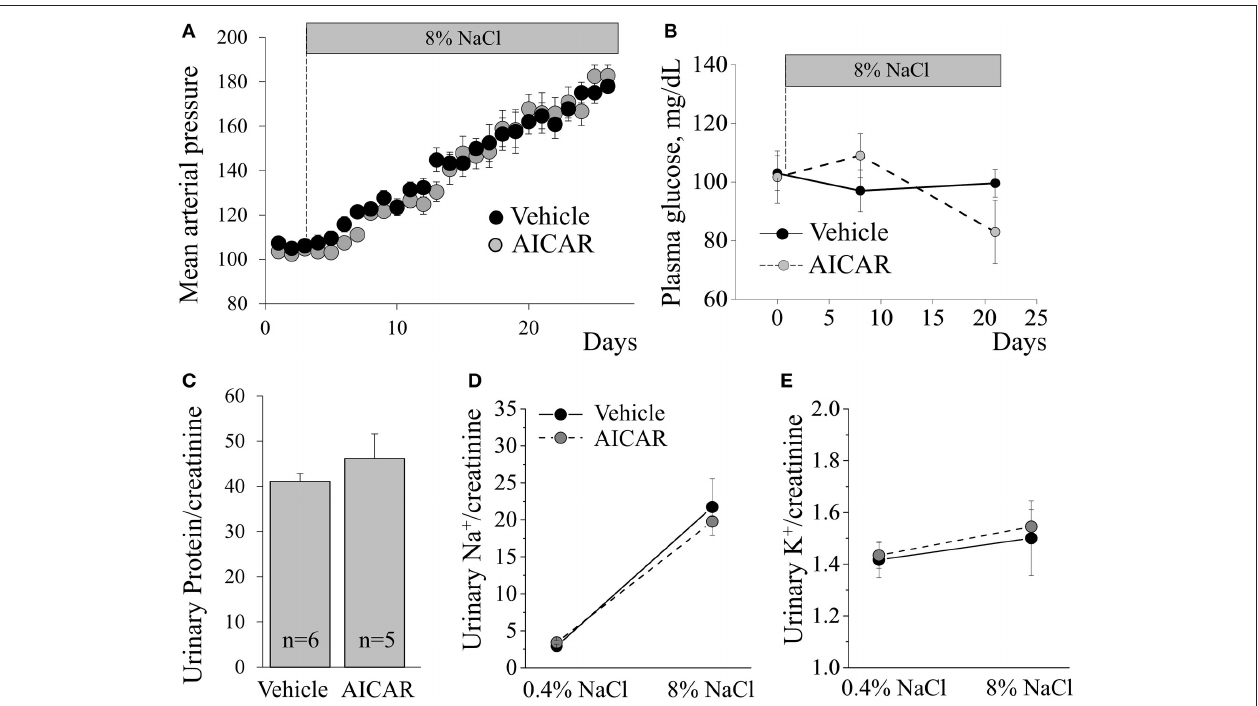
FIGURE 5 | AICAR does not alter development of SS hypertension. (A) Blood pressure recordings collected from vehicle- or AICAR-treated Dahl SS rats during development of hypertension on an 8% NaCl diet ( n = 6 and 5, respectively). Effect of AICAR treatment on the blood glucose level (B) , proteinuria (C) , sodium (D) , and potassium (E) excretion in Dahl SS rats fed an 8% diet. No significant differences between vehicle and AICAR-treated rats were found on any of the parameters